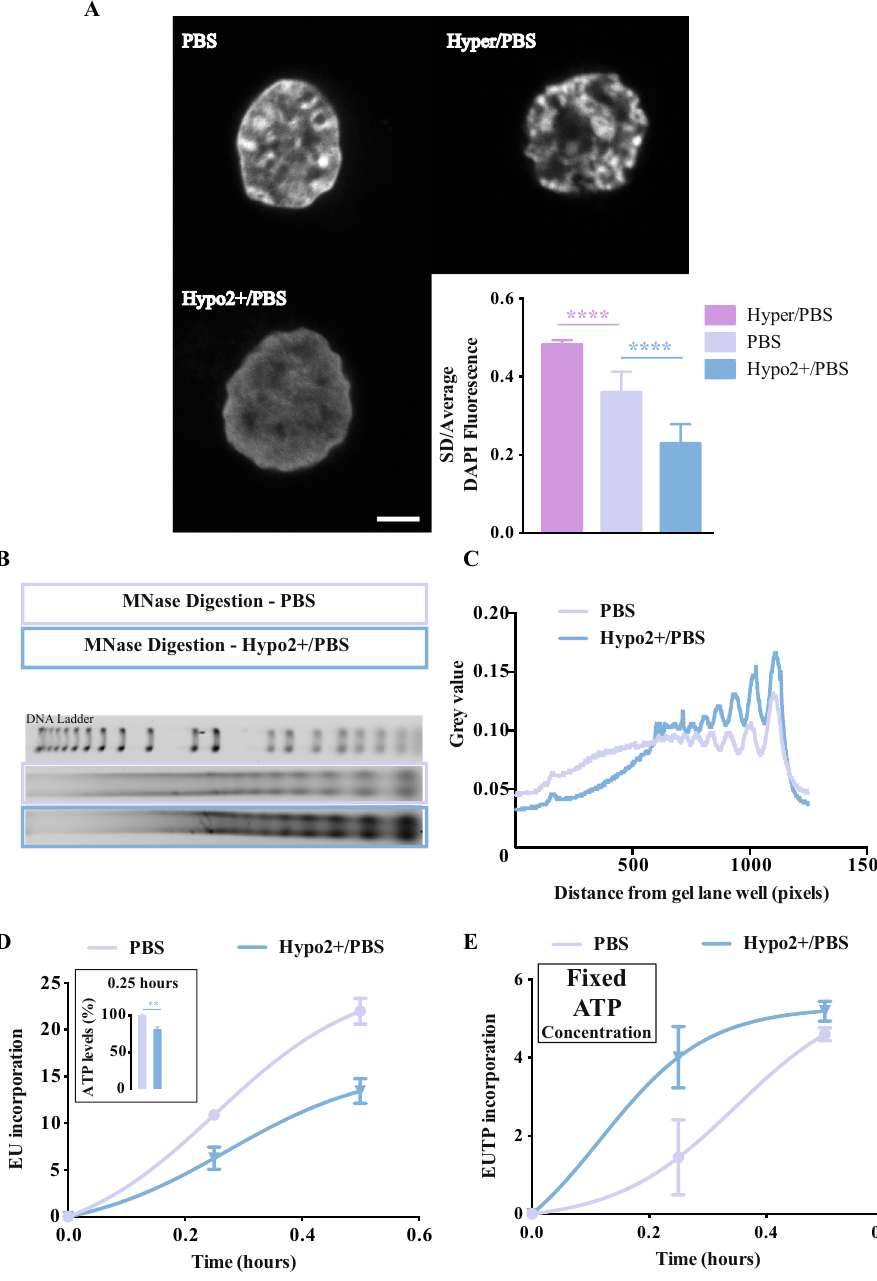
Figure 2. Impact of different osmotic environments in nuclear structure, chromatin organization and transcription. ( A ) Confocal imaging with DAPI stained K562, fixed and imaged straight after exposure to different osmotic modulations (scale bar = 2 μ m) and respective coefficient of variance of the DAPI staining (approximately 100 cells per condition were analysed). ( B ) DNA fragmentation pattern after MNase digestion (150 gel units) using K562 cells that were transiently in different osmotic conditions (cropped lanes from the original gel image provided in Supplementary Fig. S6C). ( C ) Representative histogram of the DNA fragmentation pattern of MNase digestion presented in B. The digestion pattern was analysed in Image